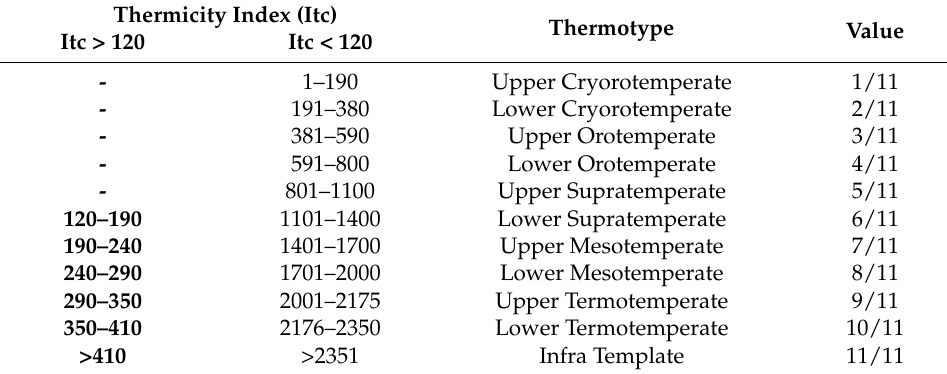
Table A8. Thermicity Index for Temperate cases assigned values [85].